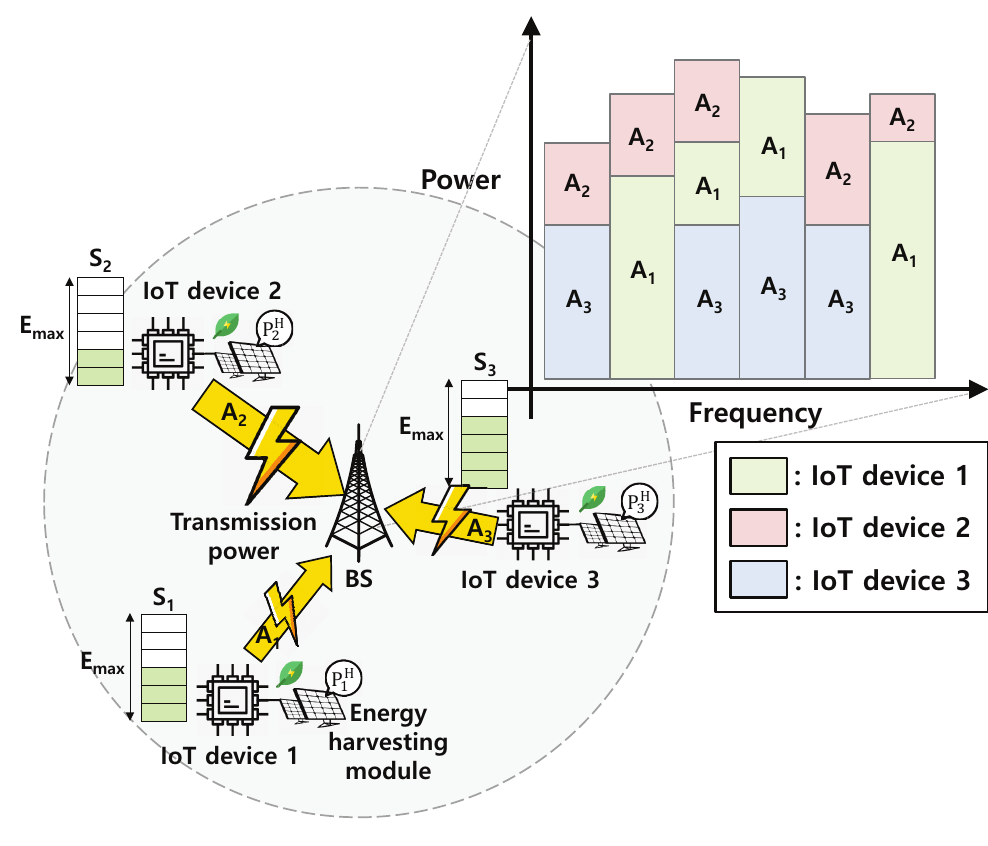
Figure 1. System